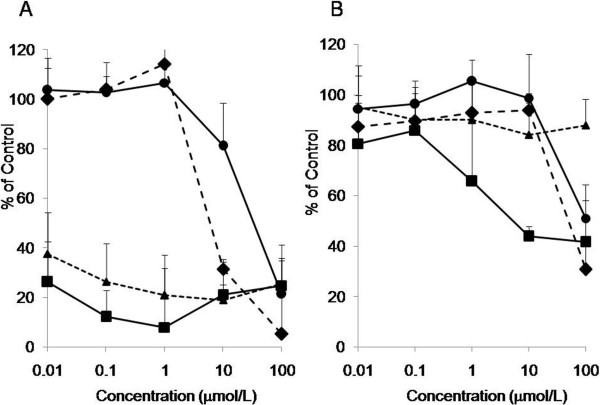
Cytotoxicity of anti-cancer agents against ES-2 cell monolayers and spheroids. ES-2 cell monolayers (A) and spheroids (B) were exposed to cisplatin (●), paclitaxel (▲), SN-38 (■) and PD153035 (♦) for 48 hr. The cytotoxic activity was measured using an MTS assay (n=3 per group calculated from 3 independent experiments). The percentage of viable cells is shown relative to untreated controls.